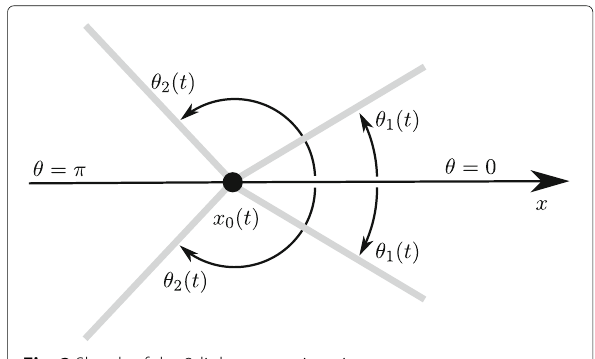
Fig. 2 Sketch of the 2-link symmetric